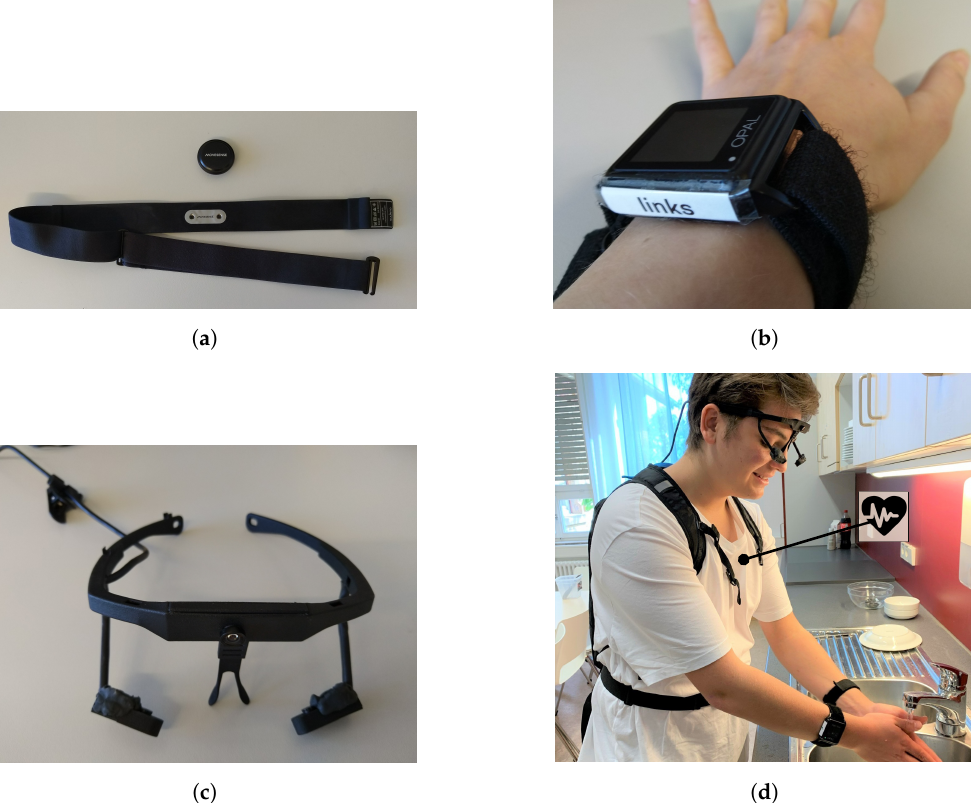
Figure 7. Illustrations of all sensors applied in SKS. ( a ) Movesense ECG and movement sensor with breast belt. ( b ) One of two APDM Opal Movement Sensors on the left hand. ( c ) The 3D printed Look! eye tracker. ( d ) All sensors at a patient. Table 1. Overview of sensor